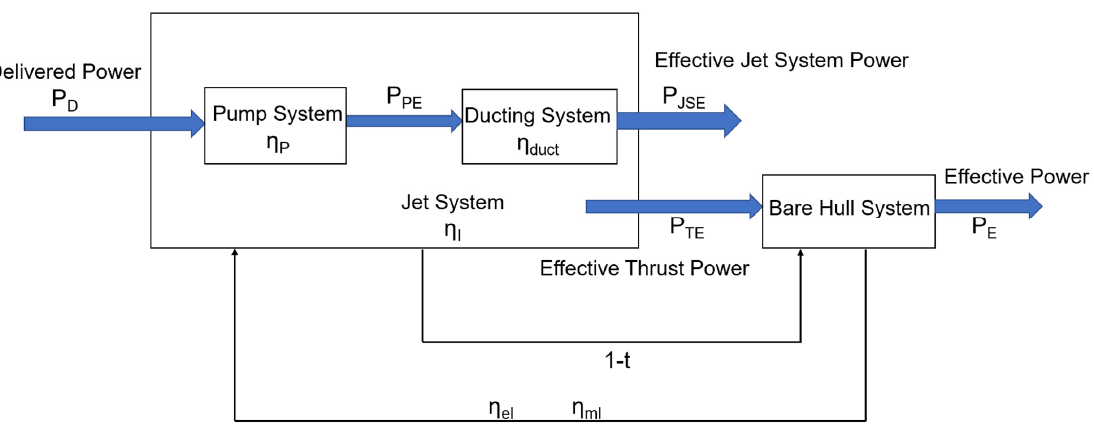
Figure 20. Energy conversion between a waterjet system and a hull.